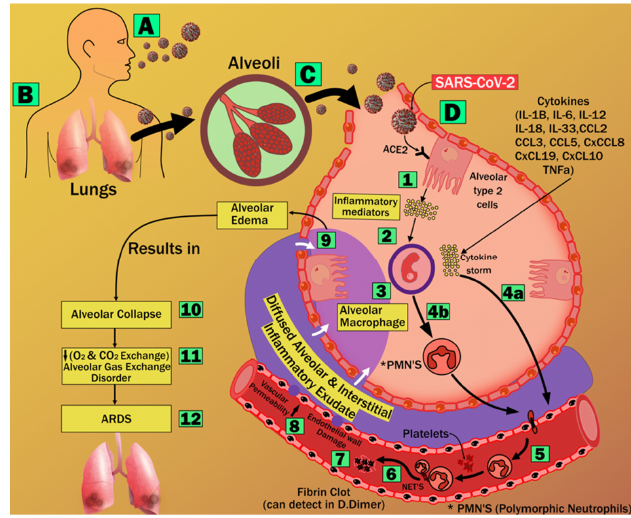
Figure A1. Stages of acute respiratory distress syndrome formation [296]. A: virus entry: Lung infection, C Alveoli complication, D: SARS-CoV-2 entry, 1: ACE2 binding, 2: Inflammatory mediators, 3: Alveolar Macrophage, 4a: cytokine storm, 4b: Polymorphic Neutrophils, 5: Diffuse exudate, 6: Platelets, 7:Fibrin clot, 8: Endothelial wall damage 9: Alveolar Edema, 10:Alveolar Collapse, 11: Alveolar gas exchange disorder, 12:ARDS.